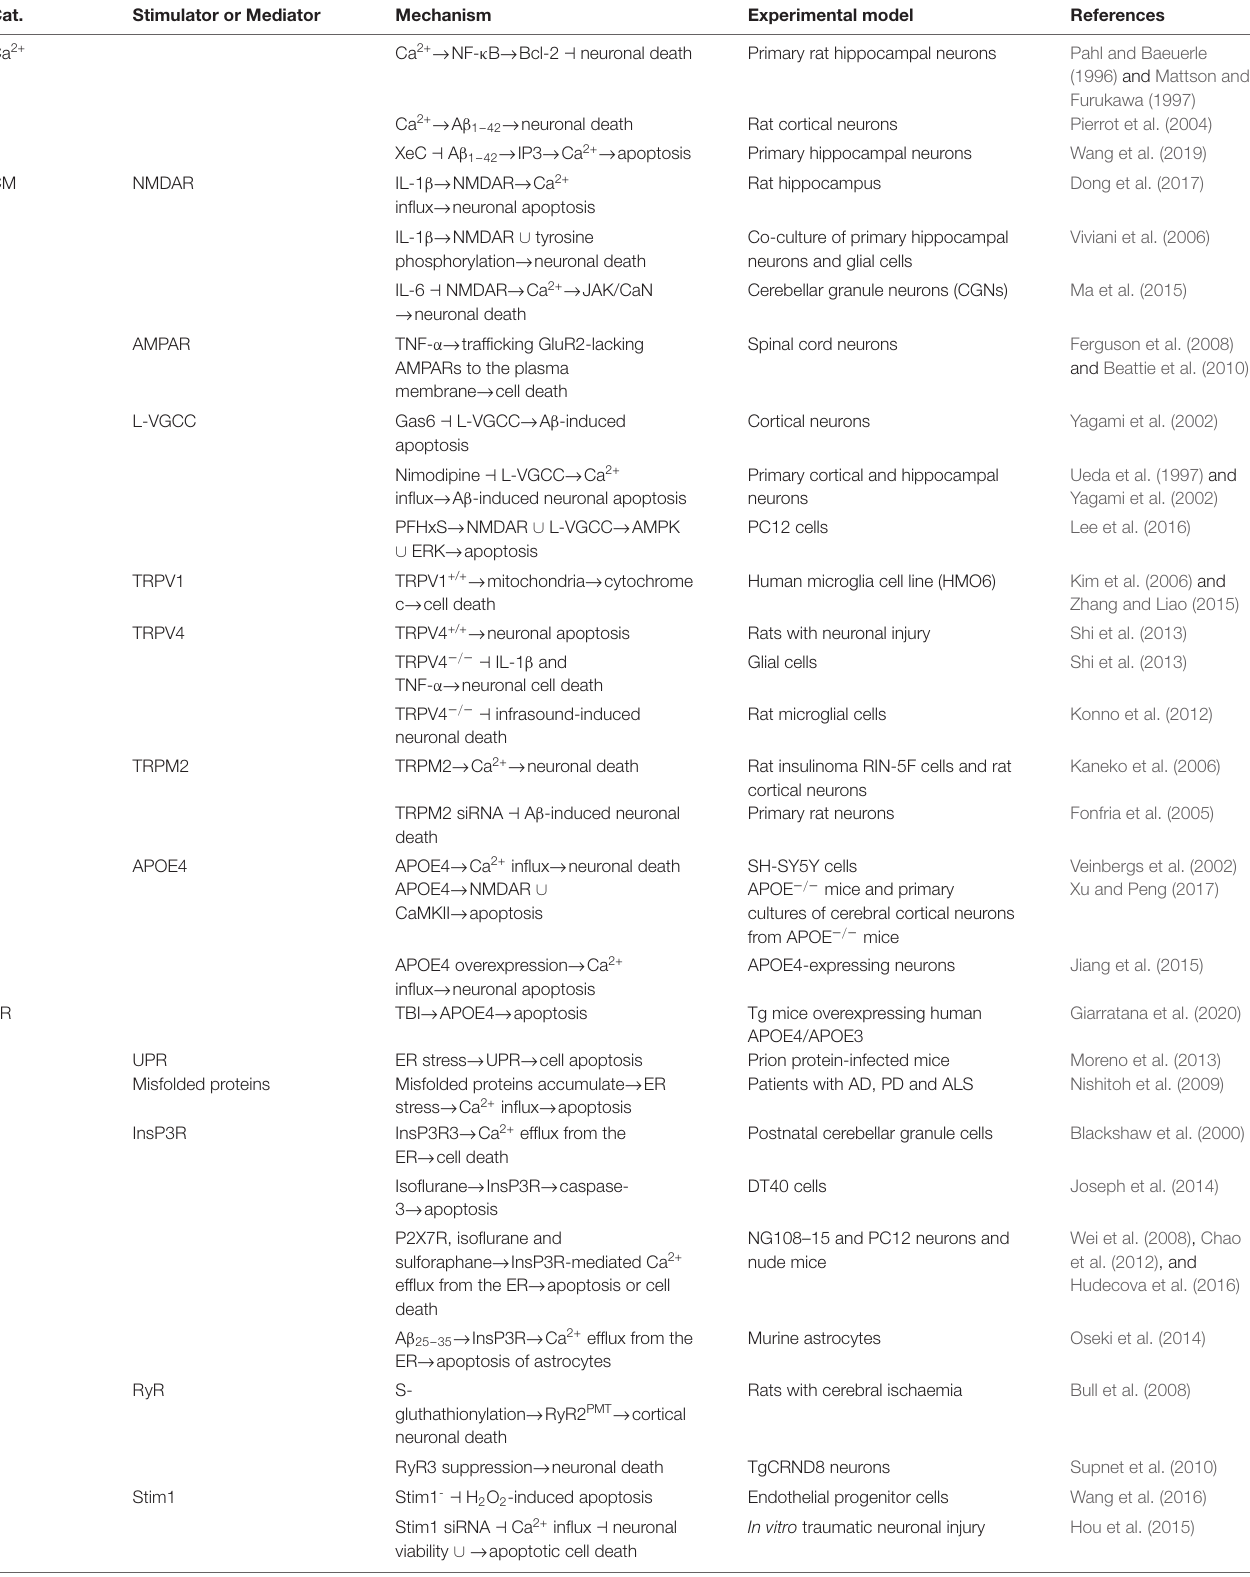
TABLE 2 | The effect of Ca 2+ on impairing neuronal functions.